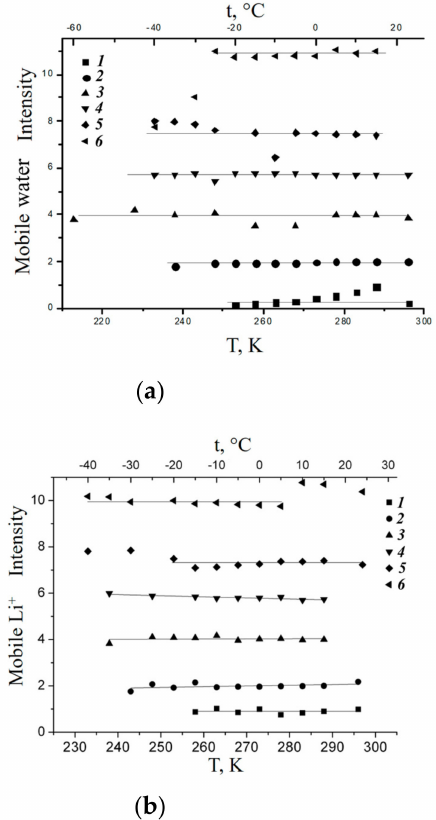
Figure 20. The dependences of mobile water molecules per sulfonated group λ ( a ) and mobile Li + cations on temperature in lithium ionic form of Nafion 117 membrane ( b ); ( a ) the amount of mobile water molecules per sulfonate group: (1) λ = 0.9, (2) λ = 2.0, (3) λ = 4.0, (4) λ = 5.7, (5) λ = 7.4, (6) λ = 10.7. ( b ) a relative intensity of 7 Li + signals: (1) λ = 0.9, (2) λ = 2.0, (3) λ = 4.0, (4) λ = 5.7, (5) λ = 7.4, (6) λ =